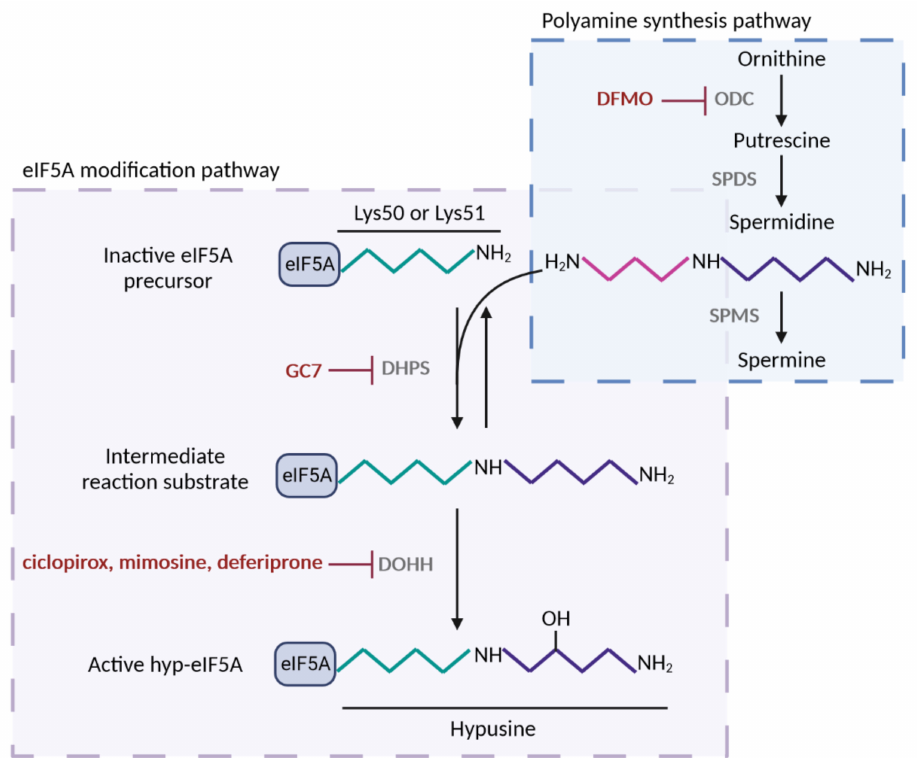
Figure 1. Polyamine-hypusine pathway and its pharmacological inhibitors. Spermidine substrate for eIF5A hypusination is obtained by the conversion of the polyamine ornithine in putrescine by the enzyme ornithine decarboxylase (ODC); next, spermidine is synthesized from putrescine by spermidine synthase (SPDS). Alternatively, spermidine is converted in spermine by spermine synthase (SPMS). Hypusine modification of lysine-50 (human) or lysine-51 (yeast) residue of eIF5A occurs by the addition of spermidine via two consecutive enzymatic reactions. First, deoxyhypusine synthase (DHPS) transfers the aminobutyl group of spermidine to the amino group of lysine generating an intermediate substrate, which does not accumulate. Second, deoxyhypusine hydroxylase (DOHH) adds a hydroxyl group and forms the hypusine residue of eIF5A, which confers the activity to the protein. eIF5A post-translational modification can be suppressed by inhibitors of DHPS and DOHH, but also by inhibition of ODC, the rate limiting enzyme for spermidine biosynthesis. Figure processing was carried out using BioRender